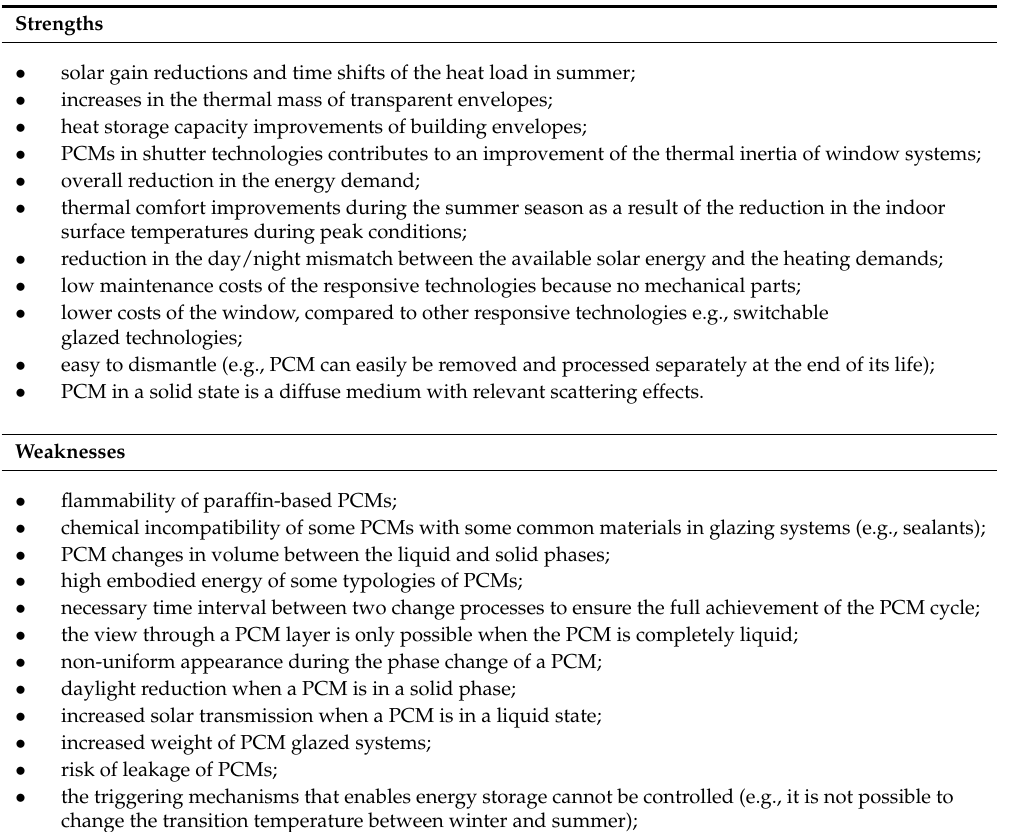
Table 6. Summary of the SWOT